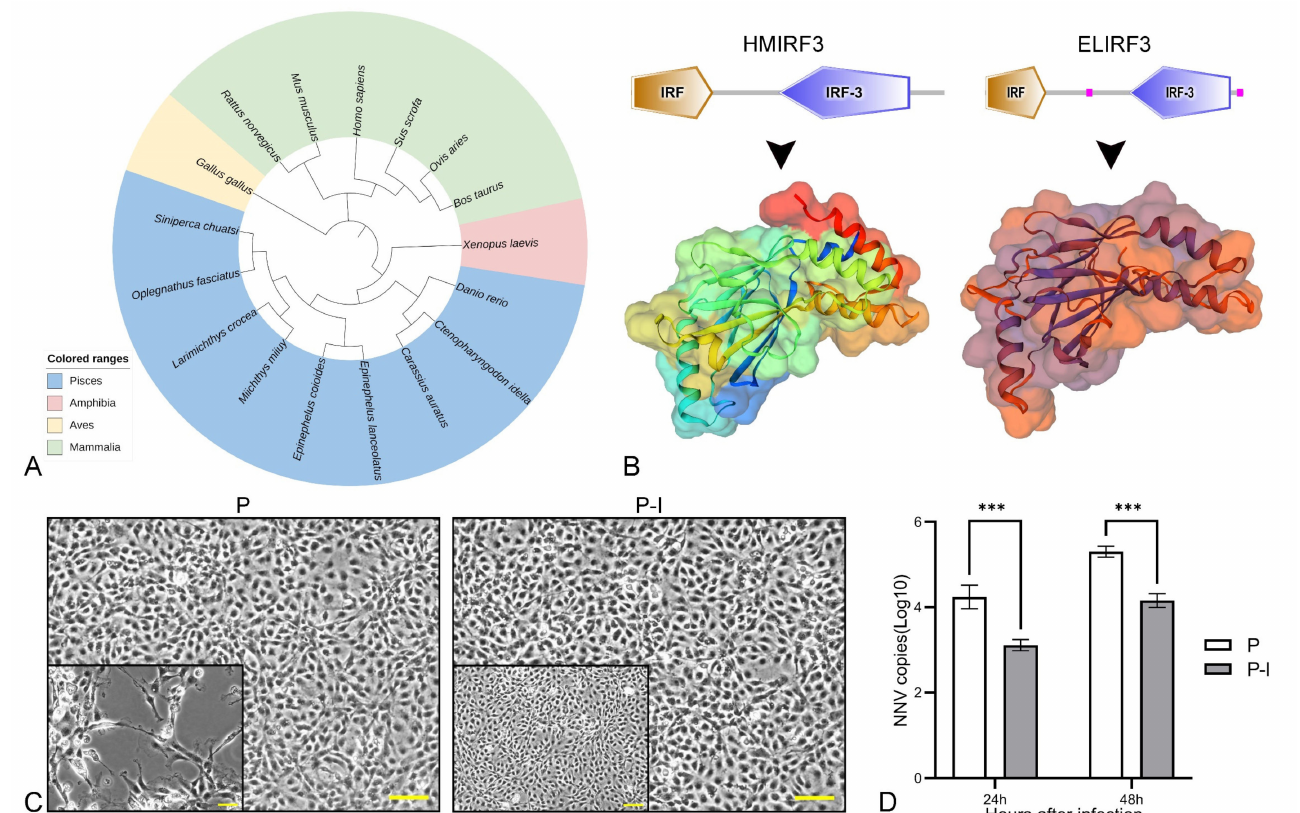
Figure 1. Bioinformatics analysis of ELIRF3 and validation of its antiviral function. Phylogenic analysis of ELIRF3 ( A ). Different colors represent different classes of animals, including Aves (light blue), Mammalia (green), Amphibia (pink), and Pisces (yellow). Prediction of protein domains and 3D models of Homo sapiens IRF3 (HMIRF3) and Epinephelus lanceolatus IRF3 (ELIRF3) ( B ). Cells ( C ) at 24 h after infection and qPCR results ( D ) of 24 h and 48 h after infection with NNV. Scale bar, 50 µ m. P: pBudCE4.1 group; P-I: pBudCE4.1-IRF3 group. The data are presented as the means ± SD of three fish. Asterisks (*) on the bar represent the statistically significant differences, *** p < 0.001.